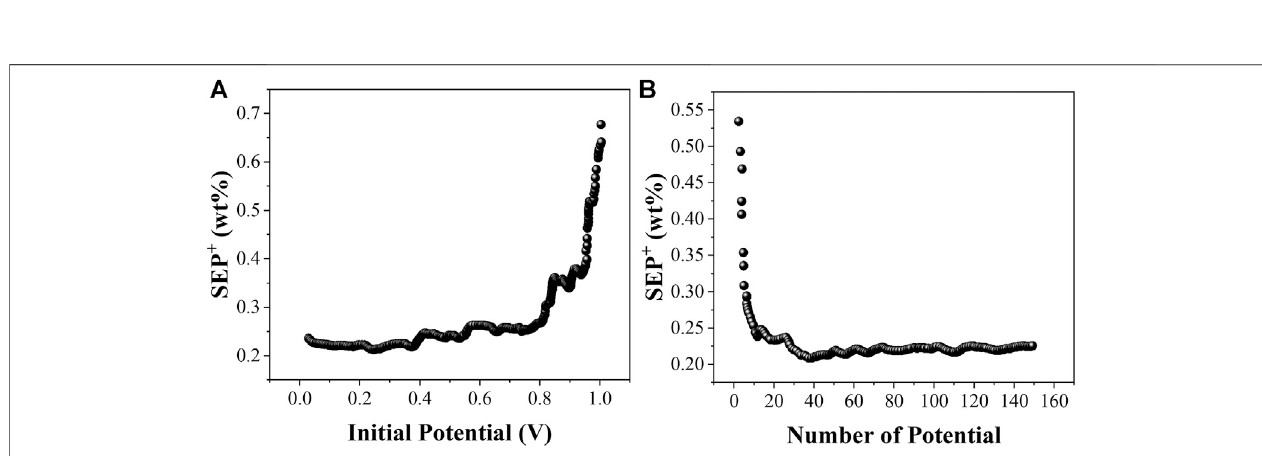
FIGURE 6 | The optimal SEP + corresponding to the starting potential I and the number of potentials N of the soil EC-PLS model for C location.